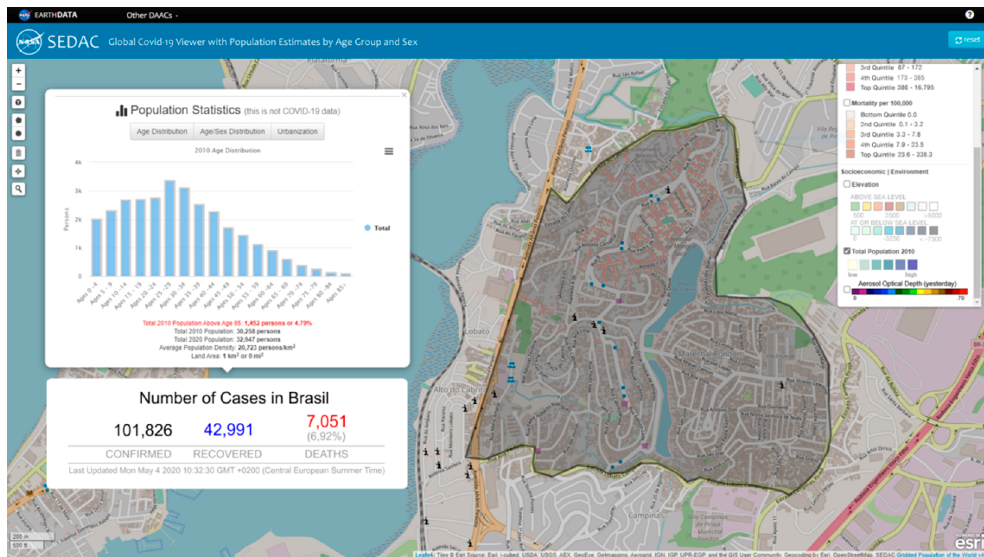
Figure 10. Socioeconomic Data and Applications Center (SEDAC) Ciesin population databases for COVID-19 responses, showing population densities, counts, and age group estimates for the two selected communities in Salvador, Brazil (Source: SEDAC, Ciesin, Columbia Univeristy).